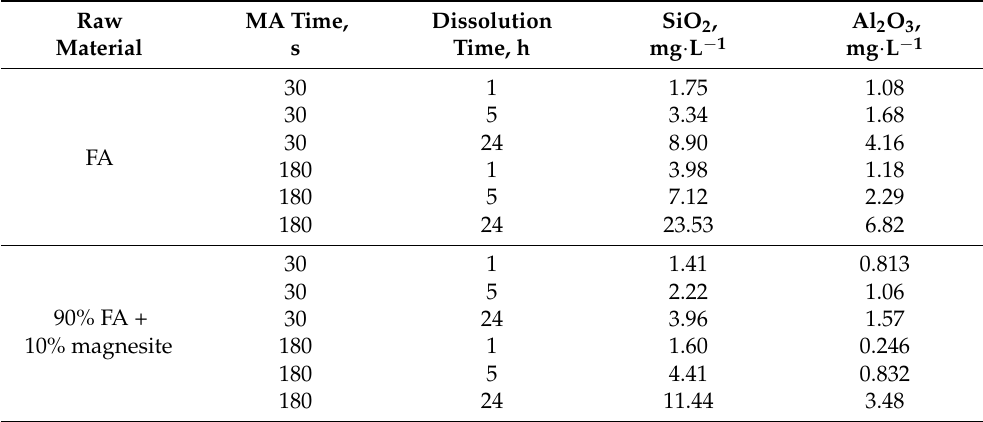
Table 3. Concentrations of SiO 2 и Al 2 O 3 after dissolution of the mechanically activated FA and (90% FA + 10% magnesite) blend in sodium hydroxide solution. 1